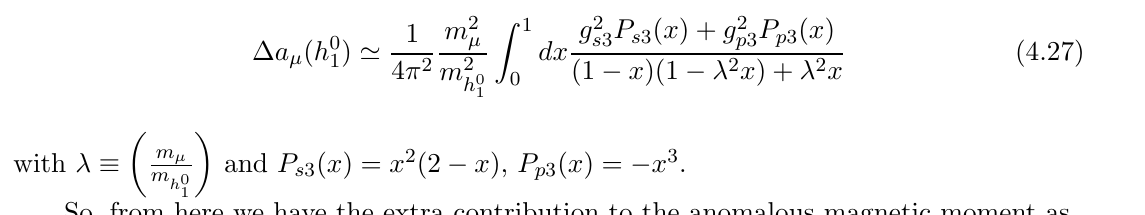
From eq. (4.26) one can see that scalar and pseudo-scalar couplings shift ( g